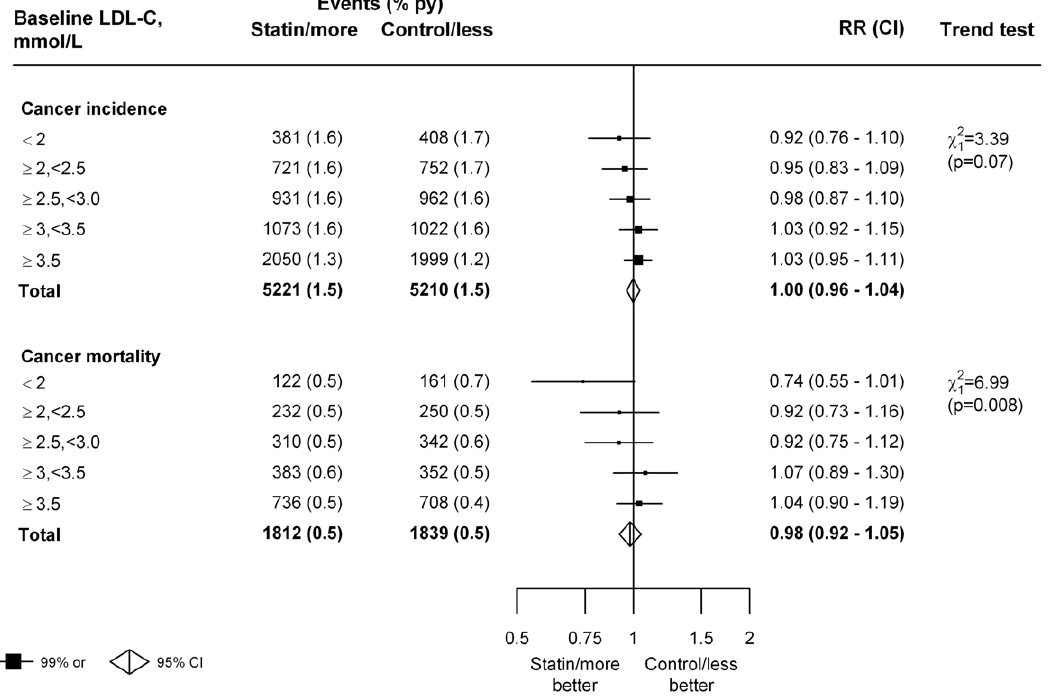
Figure 4. Effects of statin therapy on cancer incidence and mortality, by baseline LDL cholesterol. Symbols and conventions as in Figure 1. To convert from mmol/L to mg/dL divide by 0.02586.